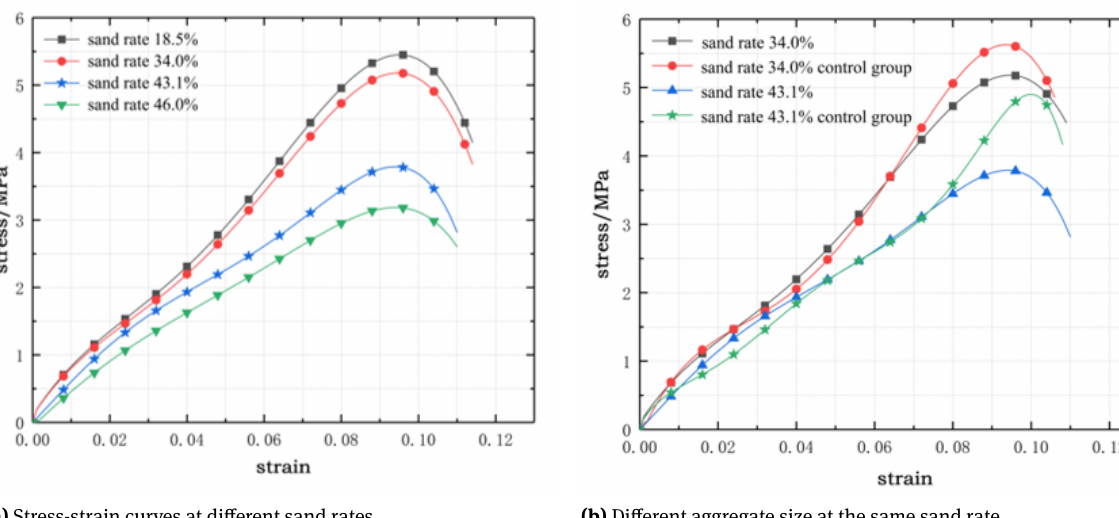
Figure 4: Simulated stress-strain curve of uniaxial compression